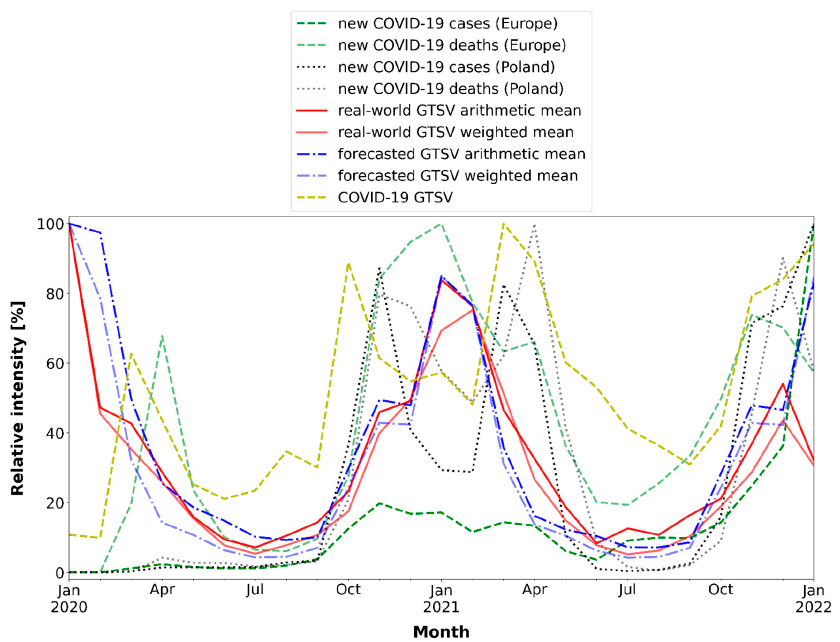
Figure 4. Changes in the COVID-19 pandemic metrics and GTSVs.